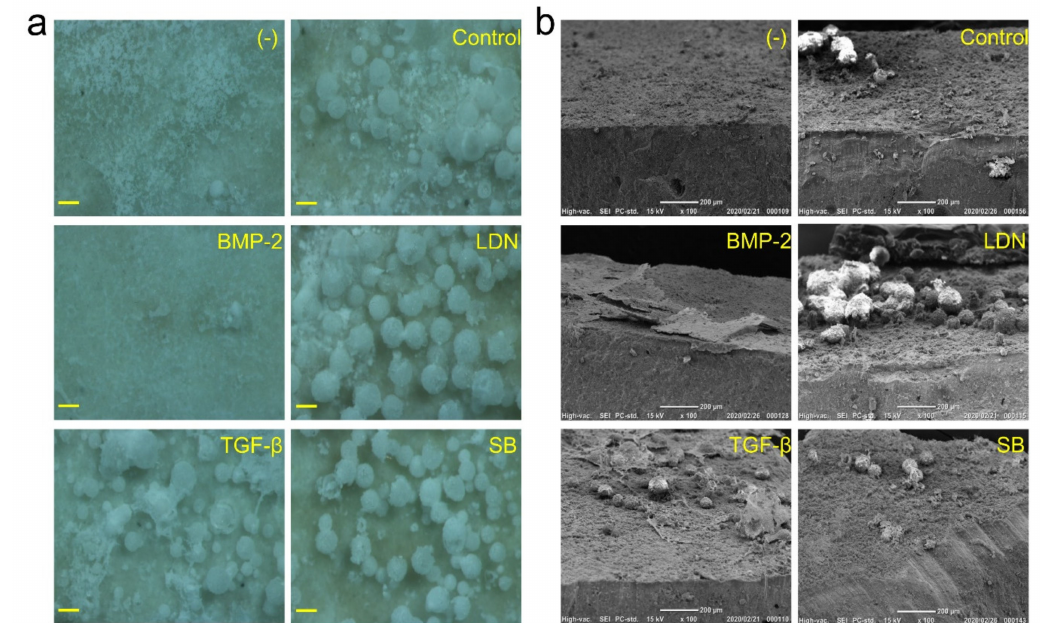
Figure 8. Morphological analysis of mineralized precipitates formed on MTA disks. ( a ) Stereomicroscope image and ( b ) SEM photograph of the surface of the MTA disk on Day 14 cultured with standard medium (-) or growth medium in the absence (control) or presence of rhBMP-2 (BMP-2), LDN-193189 (LDN), rhTGF- β 1 (TGF- β ) or SB-431542 (SB). (magnification: 100 × ; scale bar: 100 µ m for stereomicroscope image and 200 µ m for SEM).